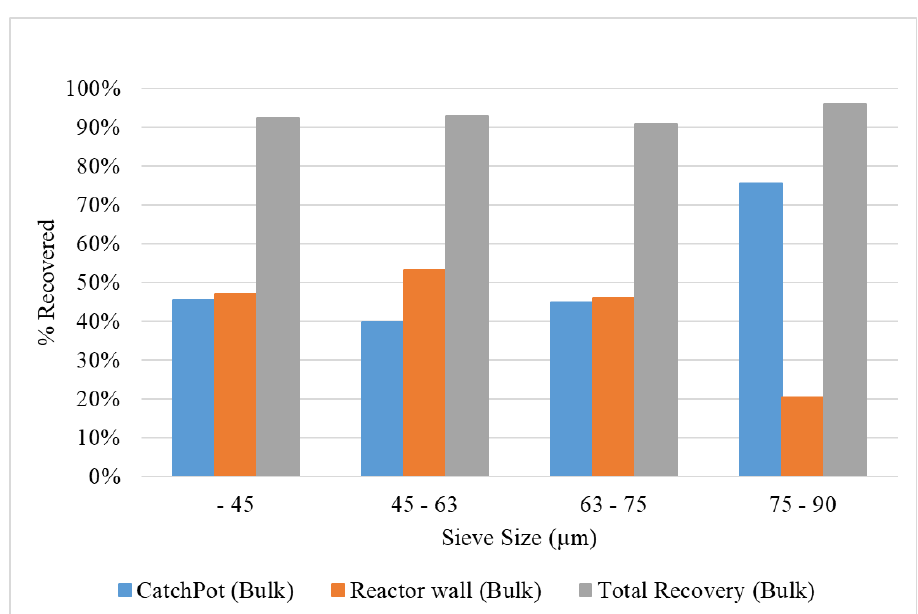
Figure 2. Product distribution for fractions after plasma treatment of control trial sample.